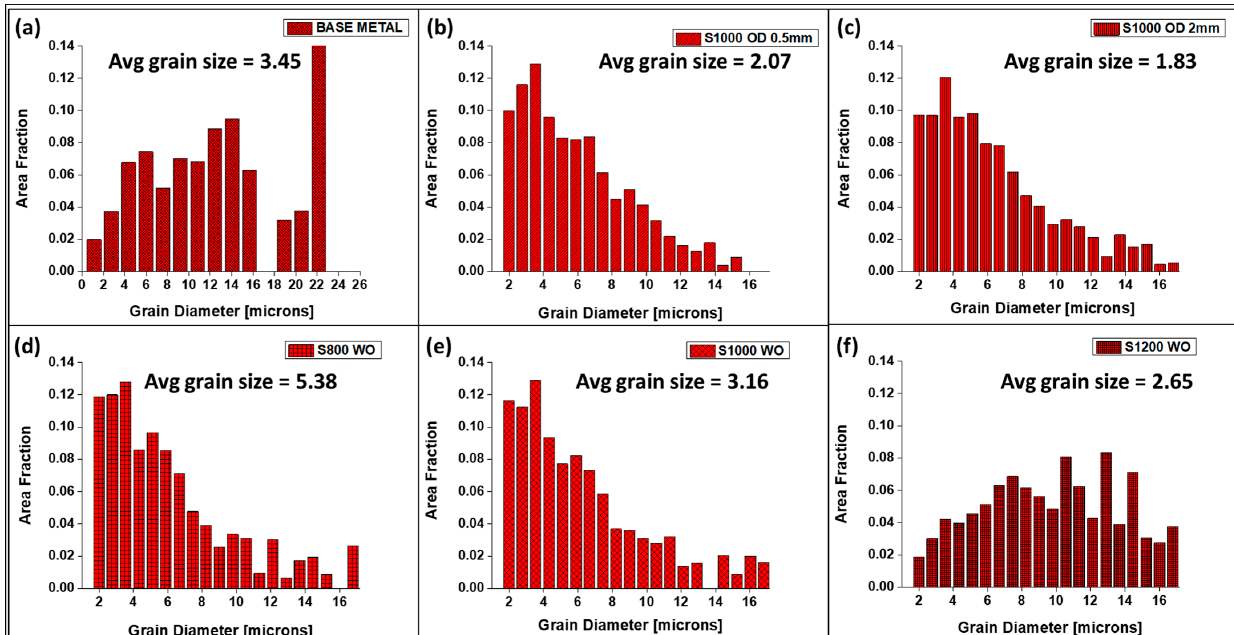
Figure 7. Grain size distribution for different sample conditions: ( a ) base metal, ( b ) S1000V60I35 OD 0.5 mm, ( c ) S1000V60I35 OD 2 mm ( d ) S800V60I35 WO, ( e ) S1000V60I35 WO and ( f ) S1200V60I35.